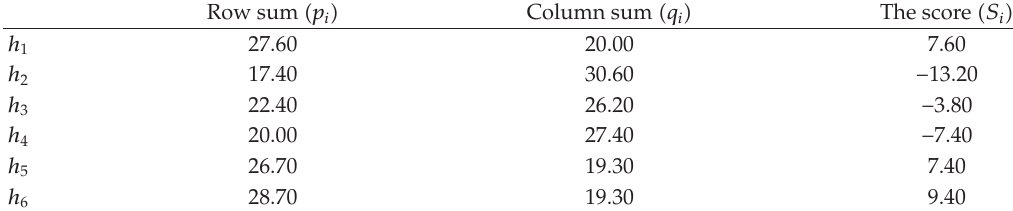
Table 6: The score of h i about (cid:2) G β